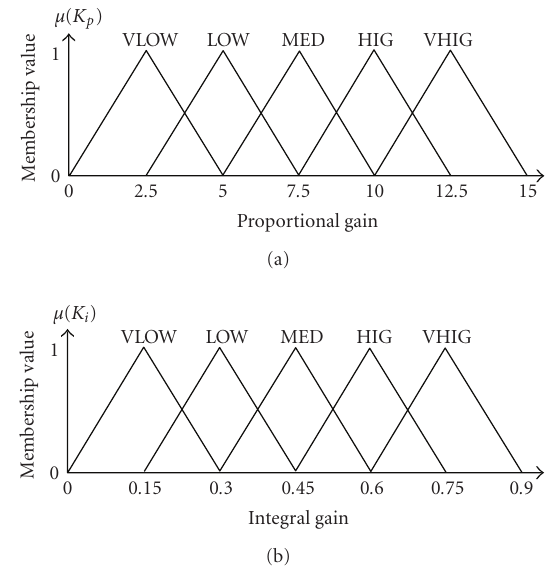
Figure 3: Fuzzy output membership functions (a) proportional gain (b) integral